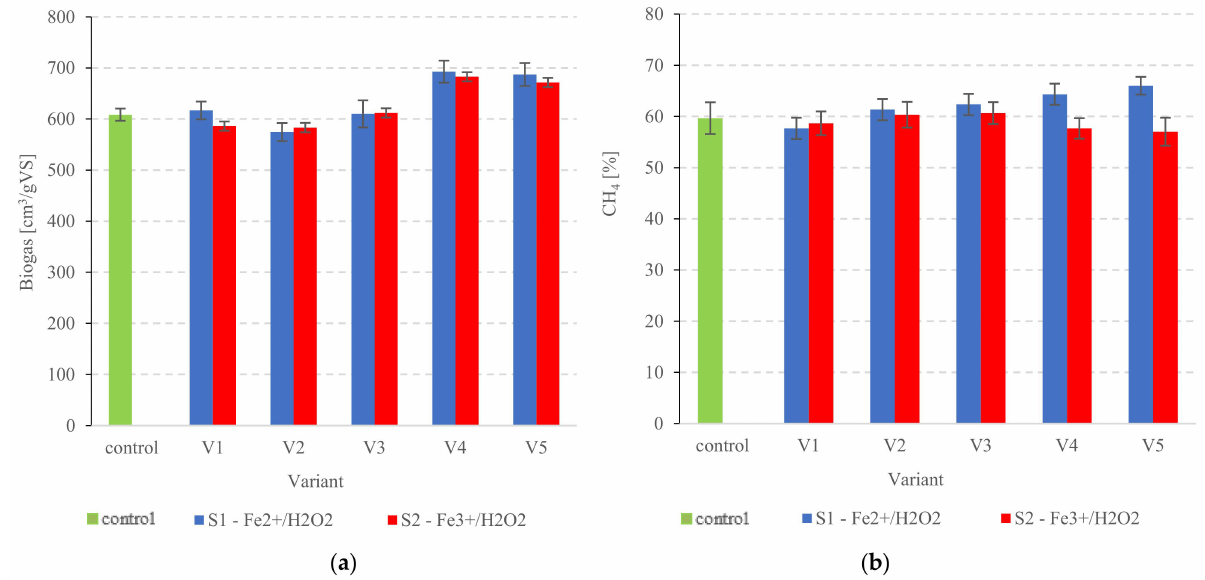
Figure 5. ( a ) Biogas production from pre-treated PSS, ( b ) CH 4 concentration in the biogas. Table 4. Portion digested and biogas/CH 4 production in relation to VS load